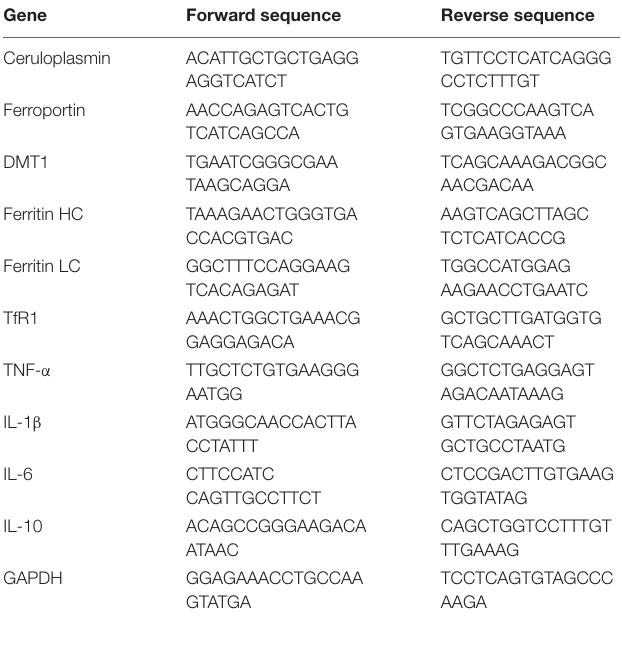
TABLE 1 | Primer sequences used for